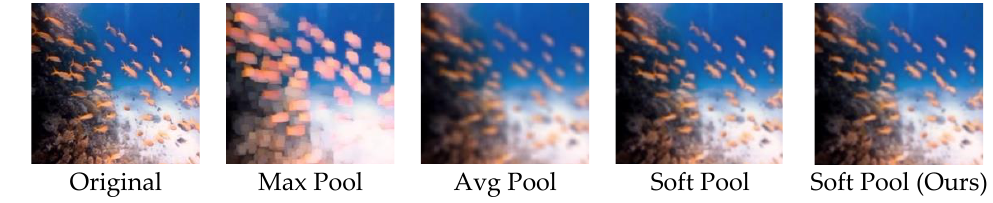
Figure 8. Results of different pooling methods.